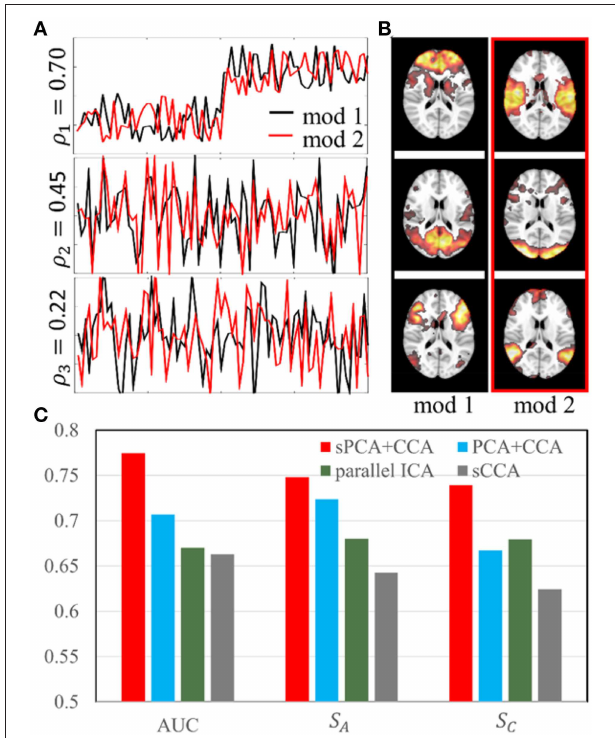
FIGURE 4 | Simulation 2: Comparison of fusion methods. (A) . Three pairs of simulated modulation profiles satisfying the orthogonality condition. (B) . Simulated spatial maps at sparsity level 70%. (C) Bar plot of the AUC measurement, similarities ( S A ) between estimated and true modulation profiles, and their corresponding spatial maps ( S C